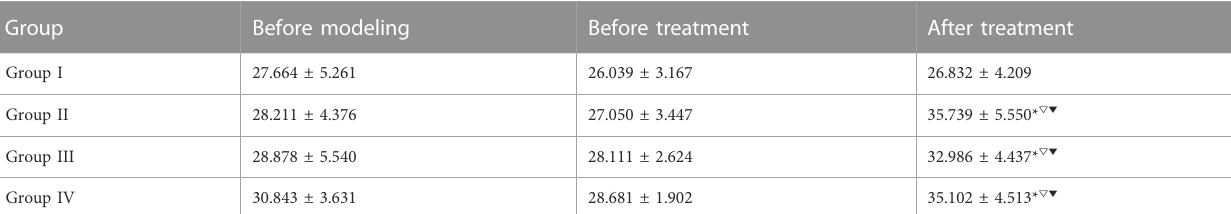
TABLE 5 TT in each group (s, ‾ x ± s).